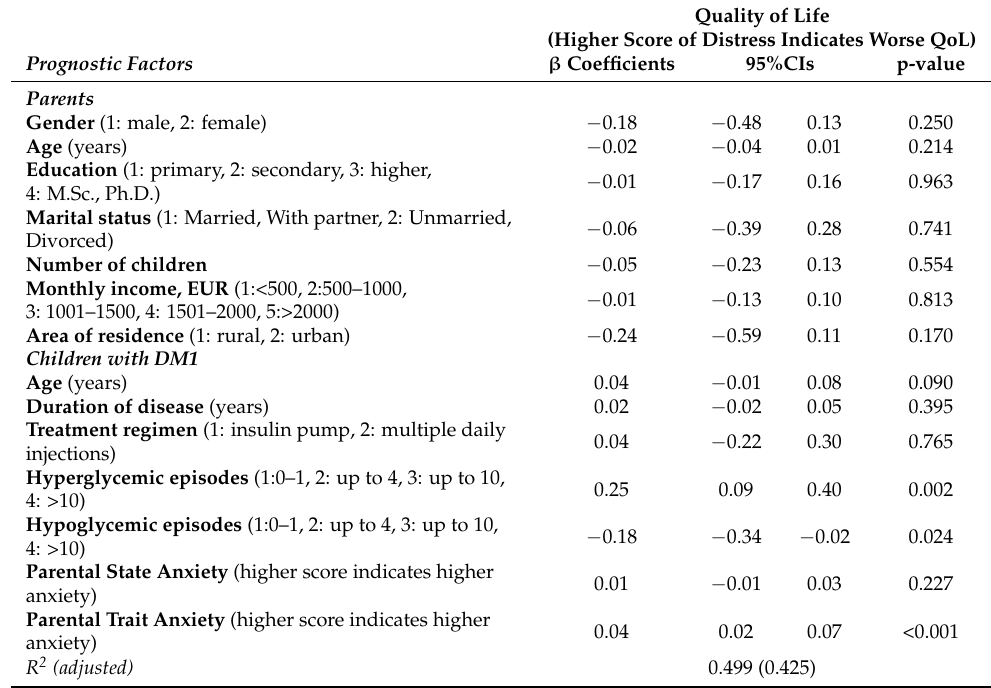
Table 4. Multiple linear regression of state and trait anxiety and characteristics of parents and children with DM1, with quality of life determined by parental distress the previous month. Quality of Life (Higher Score of Distress Indicates Worse